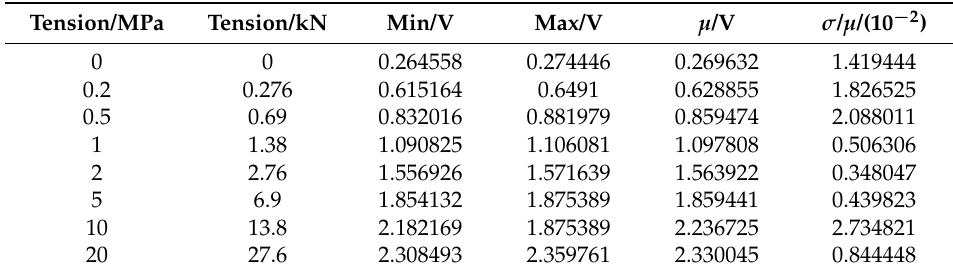
Table 2. Five test’s results.